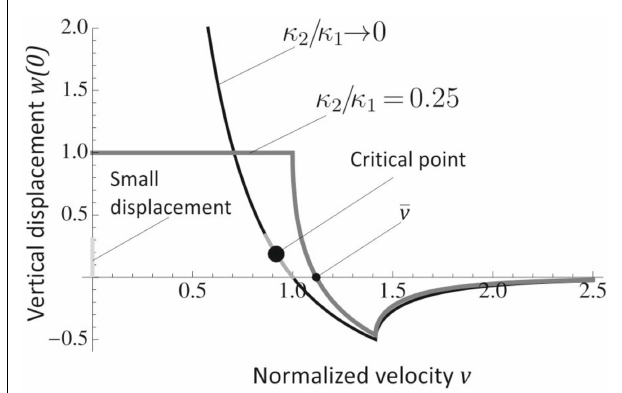
FIGURE 4 |Vertical displacement w (0) at the failure point as a function of the velocity v .The curves are shown for stiffness ratios κ 2 / κ 1 → 0 (similar to the real bridge) and κ 2 / κ 1 = 0.25.The velocity v = V /(ξ/τ) = (cid:112) ( 1 + κ 2 /κ 1 ) , corresponding to w (0) = 0 is an upper limit for the steady-state velocity of propagation. Steady-state propagation is possible only in the intersonic velocity regime, the velocity interval where the curves are monotonically decreasing.The steady-state failure configuration ( Figure 3B ) shows that the vertical displacement w (0) is of small magnitude and the critical velocity is in the left neighborhood of v = V /(ξ/τ) =